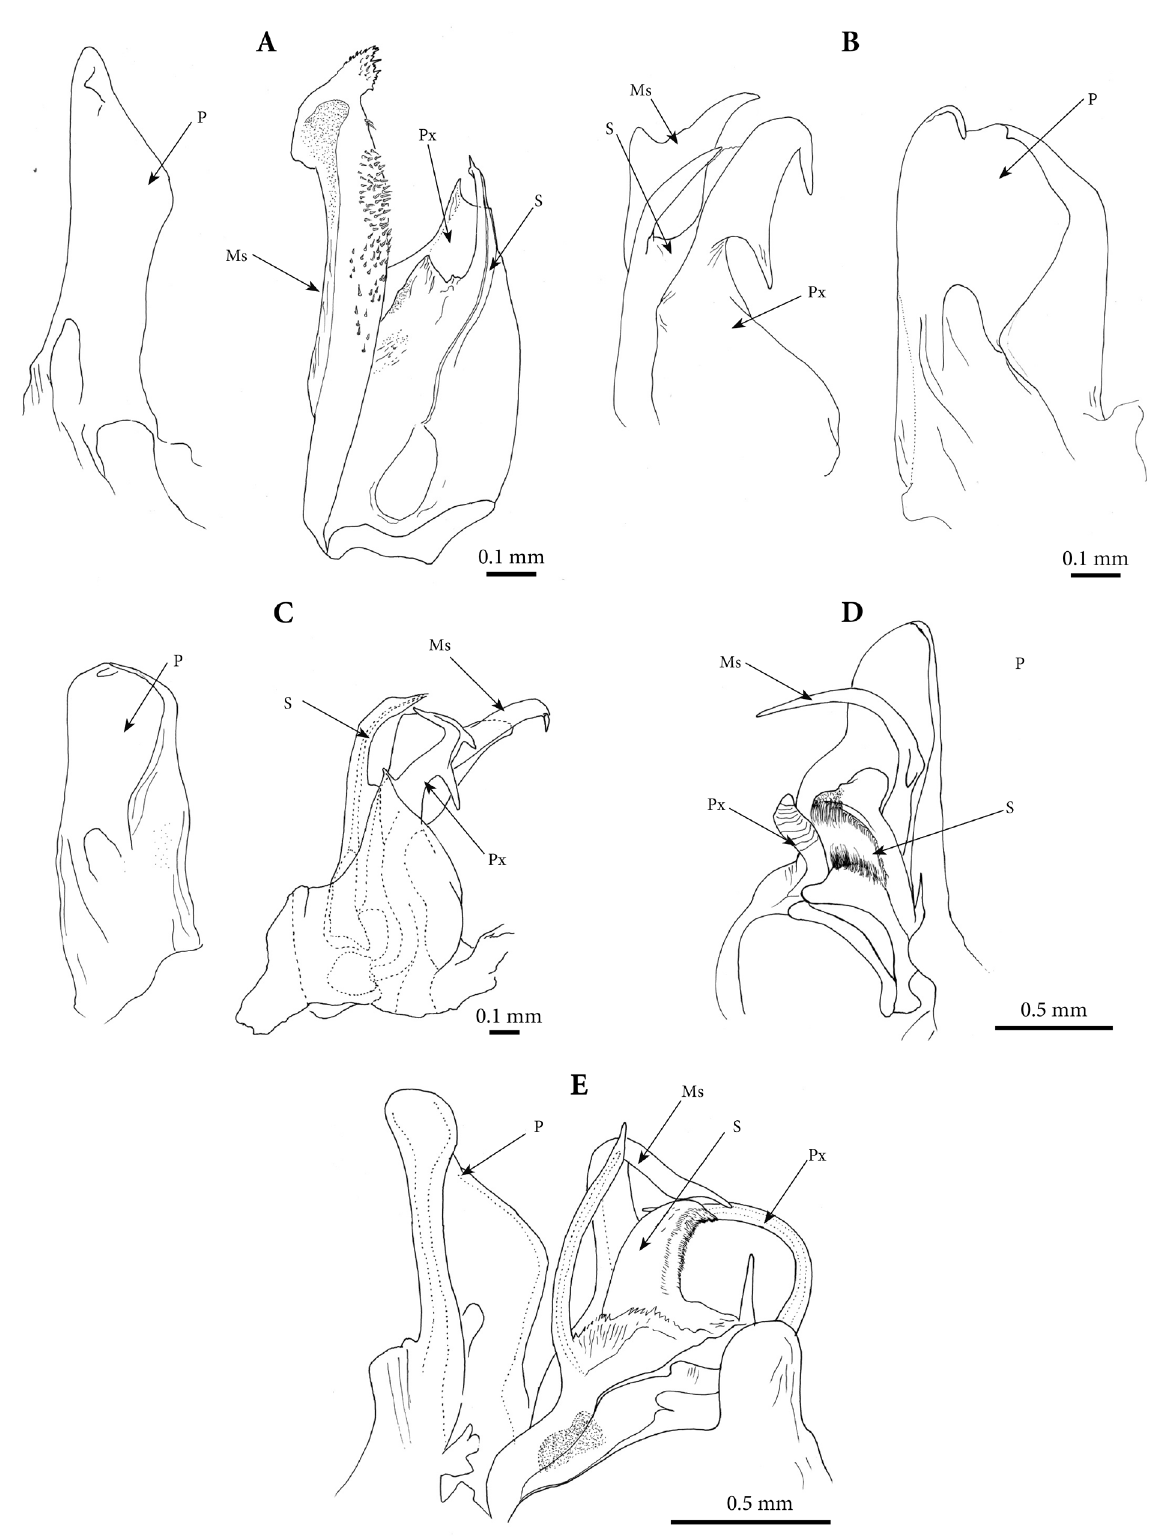
Fig. 24. A . Ommatoiulus martensi Mauriès, 1969, left gonopods. B . O. bipartitus (Verhoeff, 1925), left gonopods. C . O. moreleti (Lucas, 1860), left gonopods. D . O. dorsovittatus (Verhoeff, 1893), right gonopods. E . O. fuentei (Brolemann, 1920), left